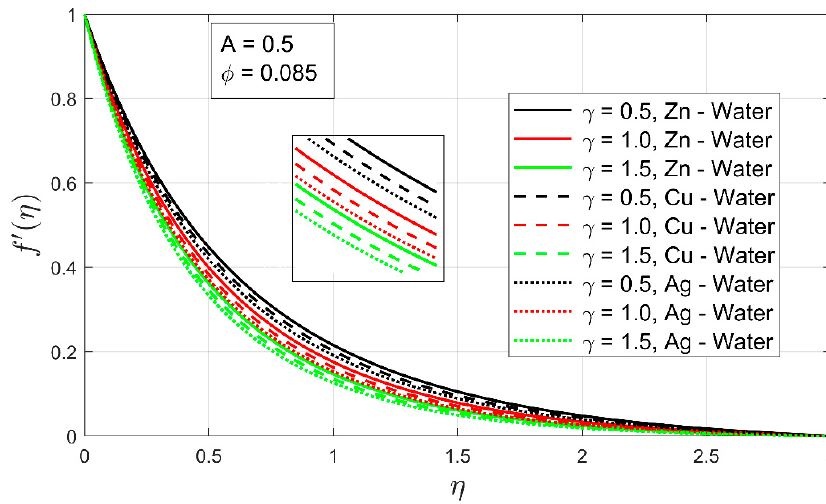
Figure 5. The influence of stretching ratio γ on velocity profile f (cid:48) ( η ) .